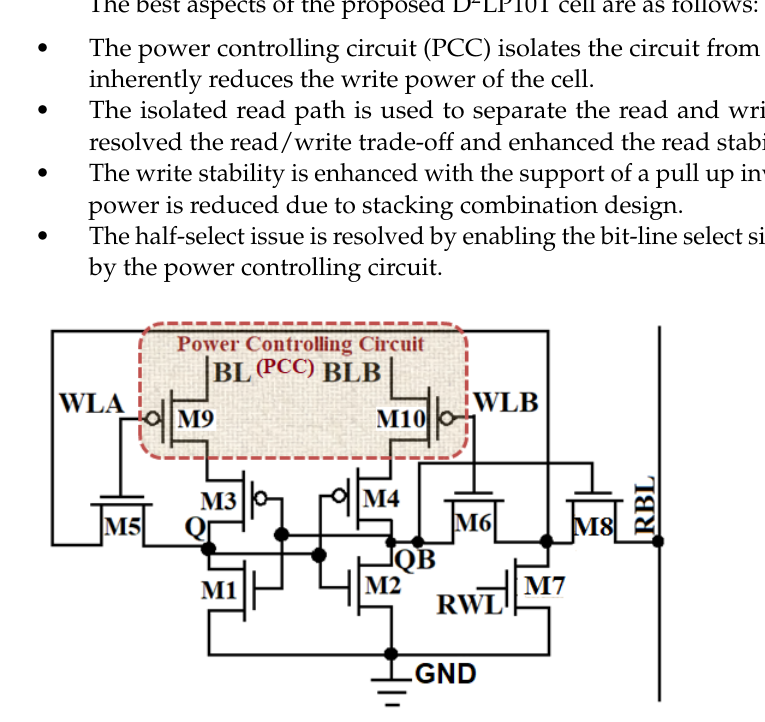
Figure 3. Circuit structure of proposed D 2 LP10T SRAM